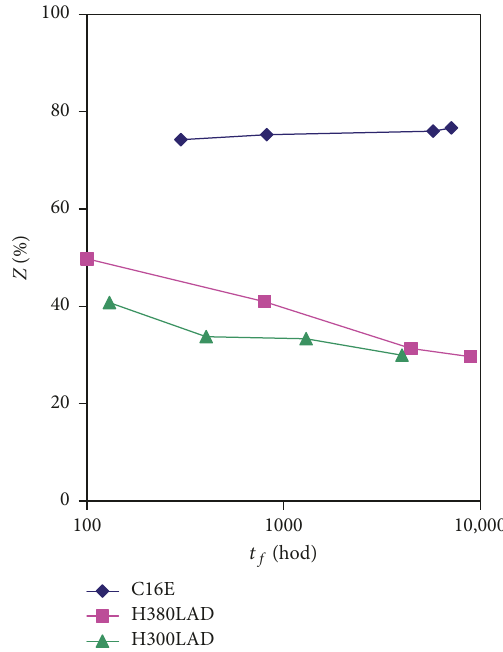
Figure 7: Dependence of the contraction ( 𝑍 ) on time to crack ( 𝑡 𝑓 ) of the tested steels at 450 ∘ C.